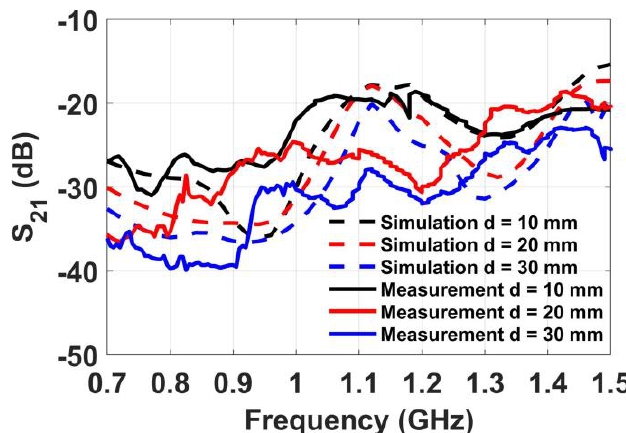
Figure 14. Simulation and measurement results (S 21 ).